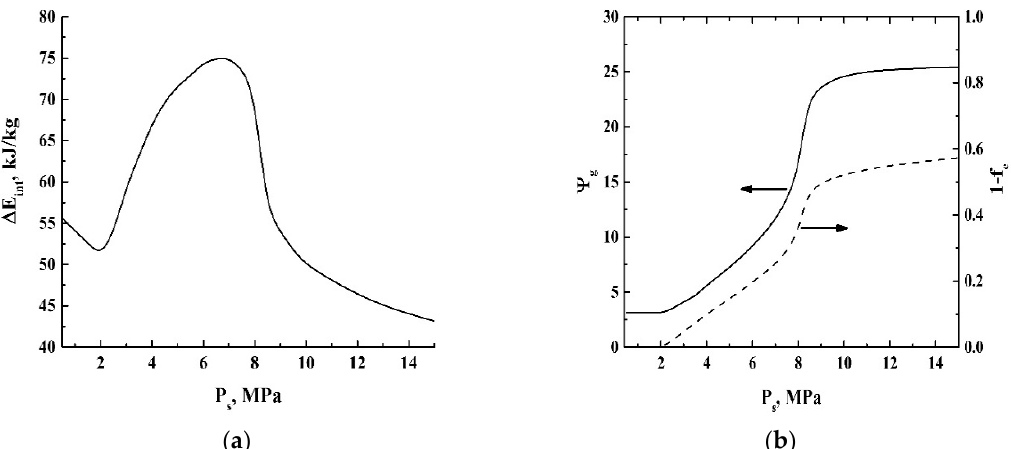
( b ) f  (the dashed line, 2) ( b ) e